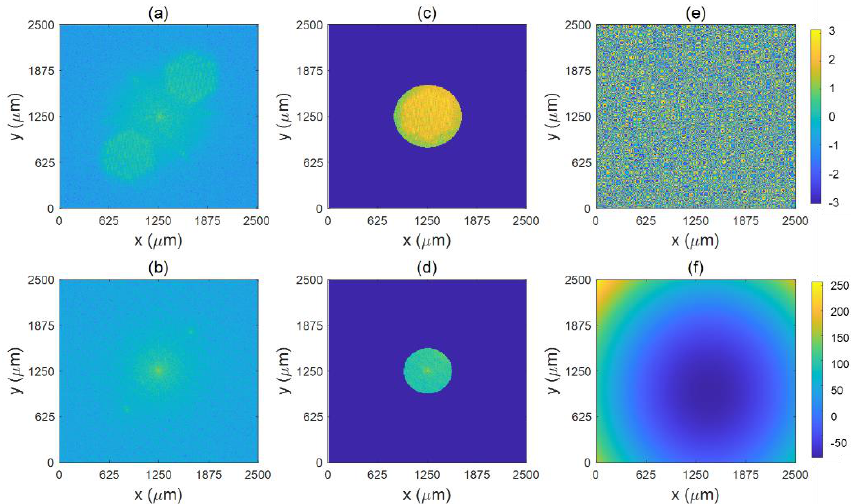
Figure 4. ( a , b ) The hologram doing the Fourier transform. ( c , d ) The frequency filtering done on ( a , b ), respectively. ( e , f ) The intensity map corresponding to the phase